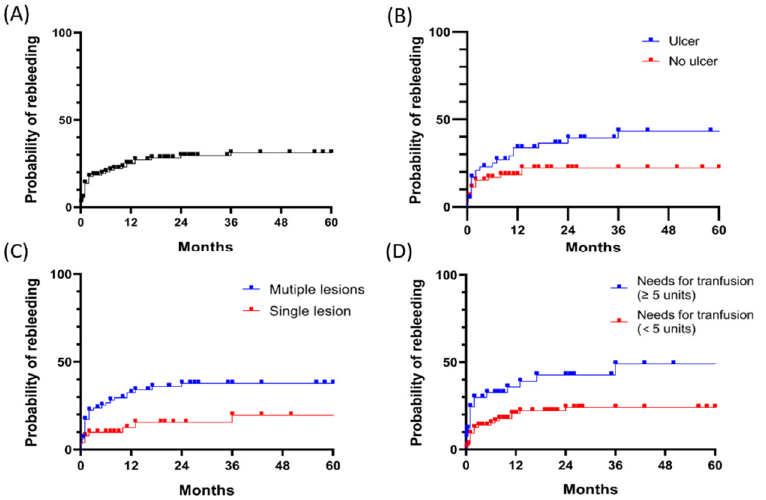
Figure 2. Cumulative incidence of rebleeding and associated factors. ( A ) All rebleeding; ( B ) Rebleeding stratified by presence of ulcer; ( C ) Rebleeding stratified by the number of lesions; ( D ) Rebleeding stratified by requirements of more than five units of RBC transfusion.